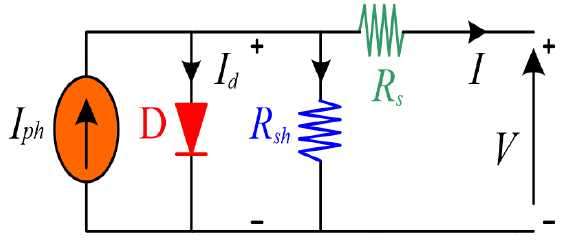
Figure 2. PV panel equivalent circuit.